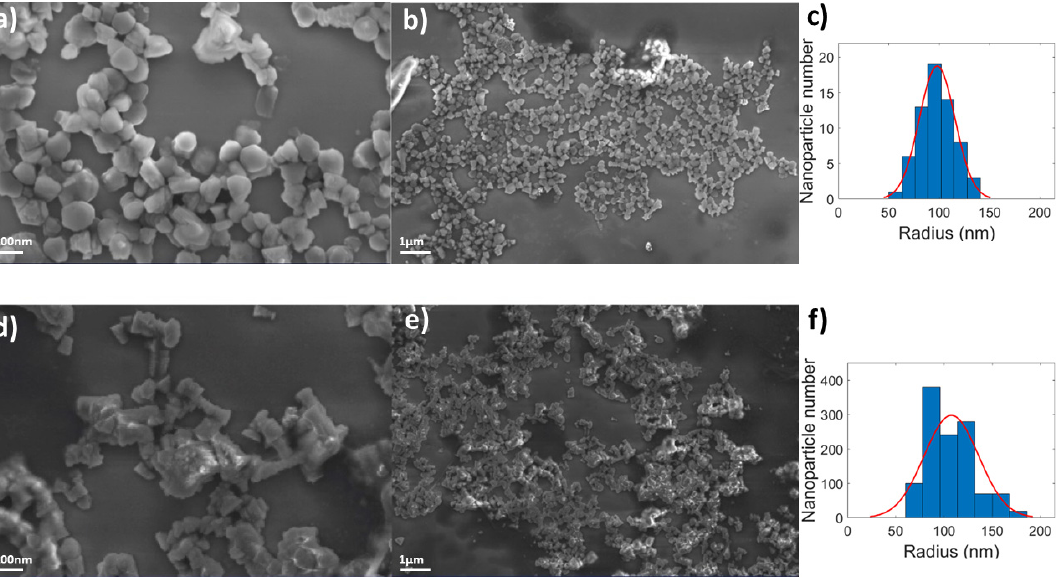
Figure 6. Scanning Electron Microscopy acquisitions ( a , b , d , e ) and dimensional distribution ( c , f ) of SOR-NPs ( a – c ) and LEN-NPs ( d – f ). Scale bars: ( a ) 200 nm; ( d , e ) 1 µm.